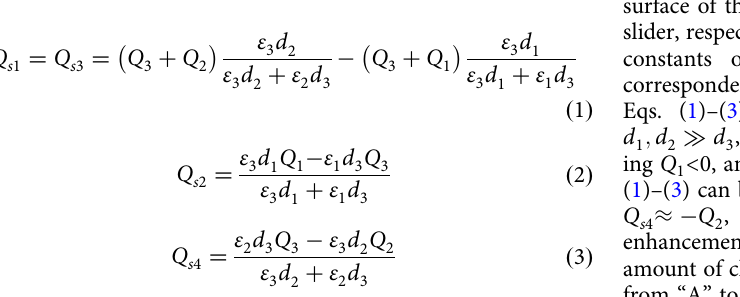
where Q , Q and Q are the amounts of charges on the FEP 1 2 3